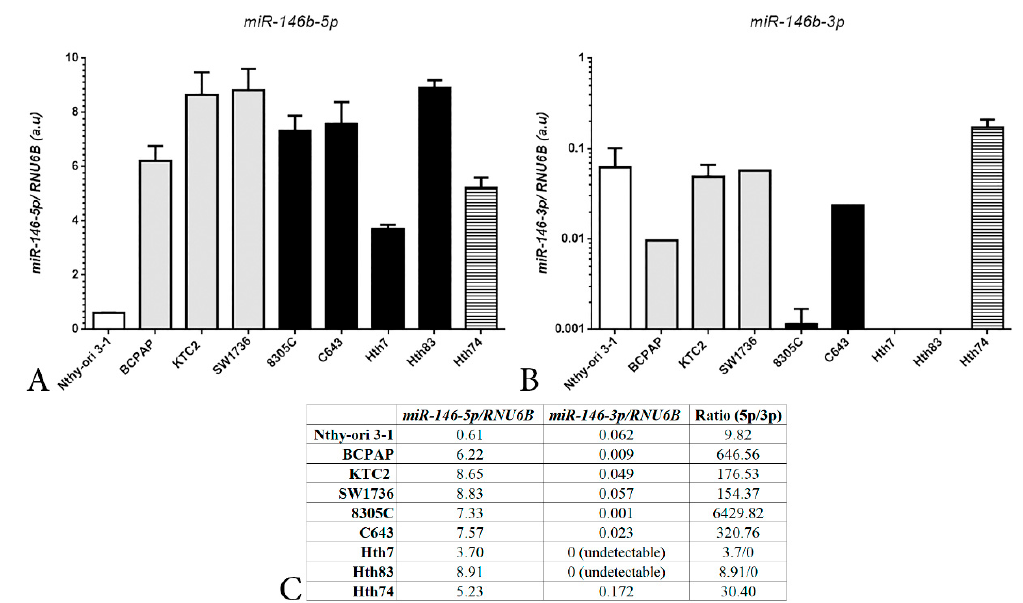
Figure 1. Expression levels of mature miR-146b - 5p ( A ) and miR-146b - 3p ( B ) in human thyroid cancer cell lines derived from PTC (BCPAP) or ATC (KTC2, 8305C, C643, Hth74 and Hth83), and as non-malignant control Nthy ori 3-1. Gene expression was calculated with Qgene using 2 − deltact . Grey bars indicate the presence of mutation BRAF V600E and black bars indicate the presence of RAS mutations, or NF1 (dashed bar). ( C ) Ratio between miR-146b-5p / miR-146b-3p expression levels calculated from data shown in panel ( A ) and panel ( B ).